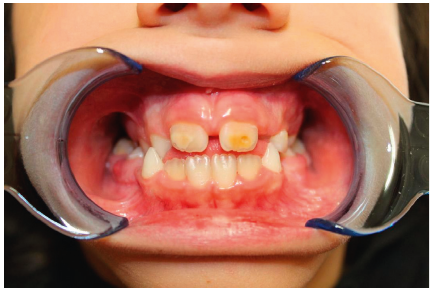
Figure 4: Severe incisor